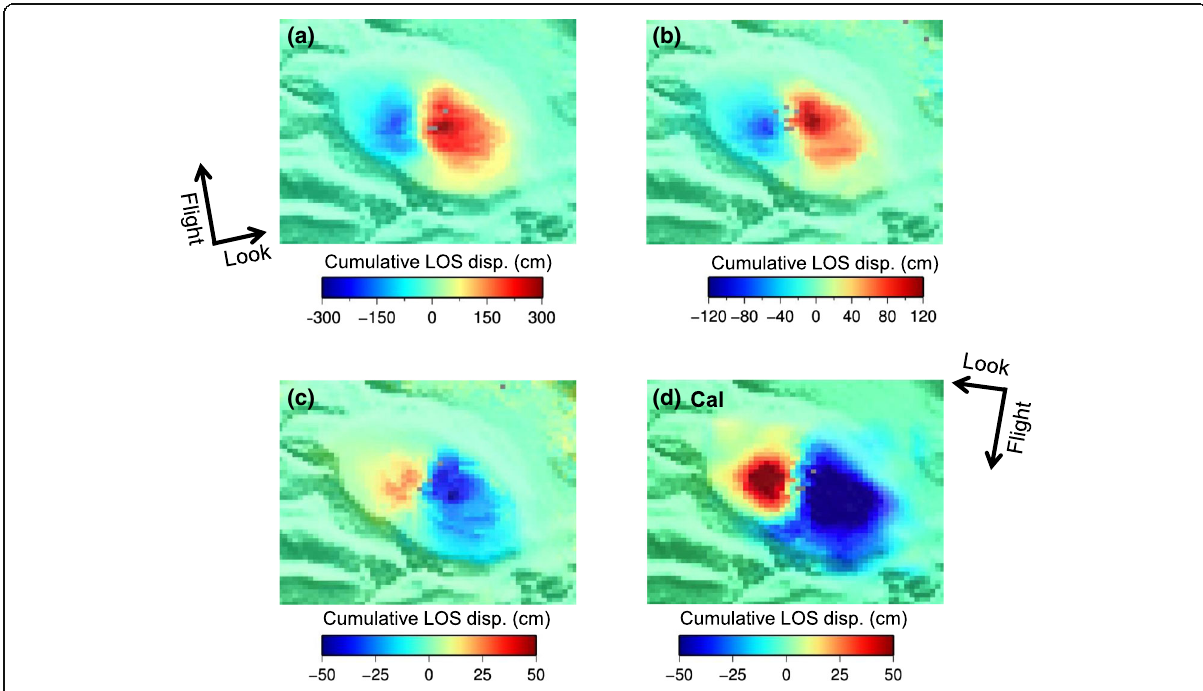
Fig. 5 Cumulative observed LOS changes derived from a ALOS/PALSAR data (P1-23), b ALOS-2/PALSAR-2 ascending data (P24 – 32), and c ALOS- 2/PALSAR-2 descending data (P33 – 35). d Calculated ALOS-2/PALSAR-2 descending data, based on the slip distribution model in Fig.